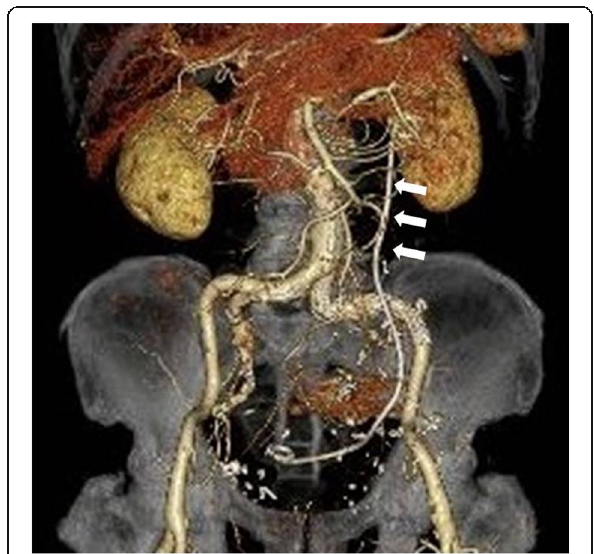
Fig. 3 Postoperative computed tomography demonstrates endovascular stent grafting from the left common iliac artery to the left external iliac artery and full occlusion of the internal iliac aneurysm. Arrows indicate the ureteral